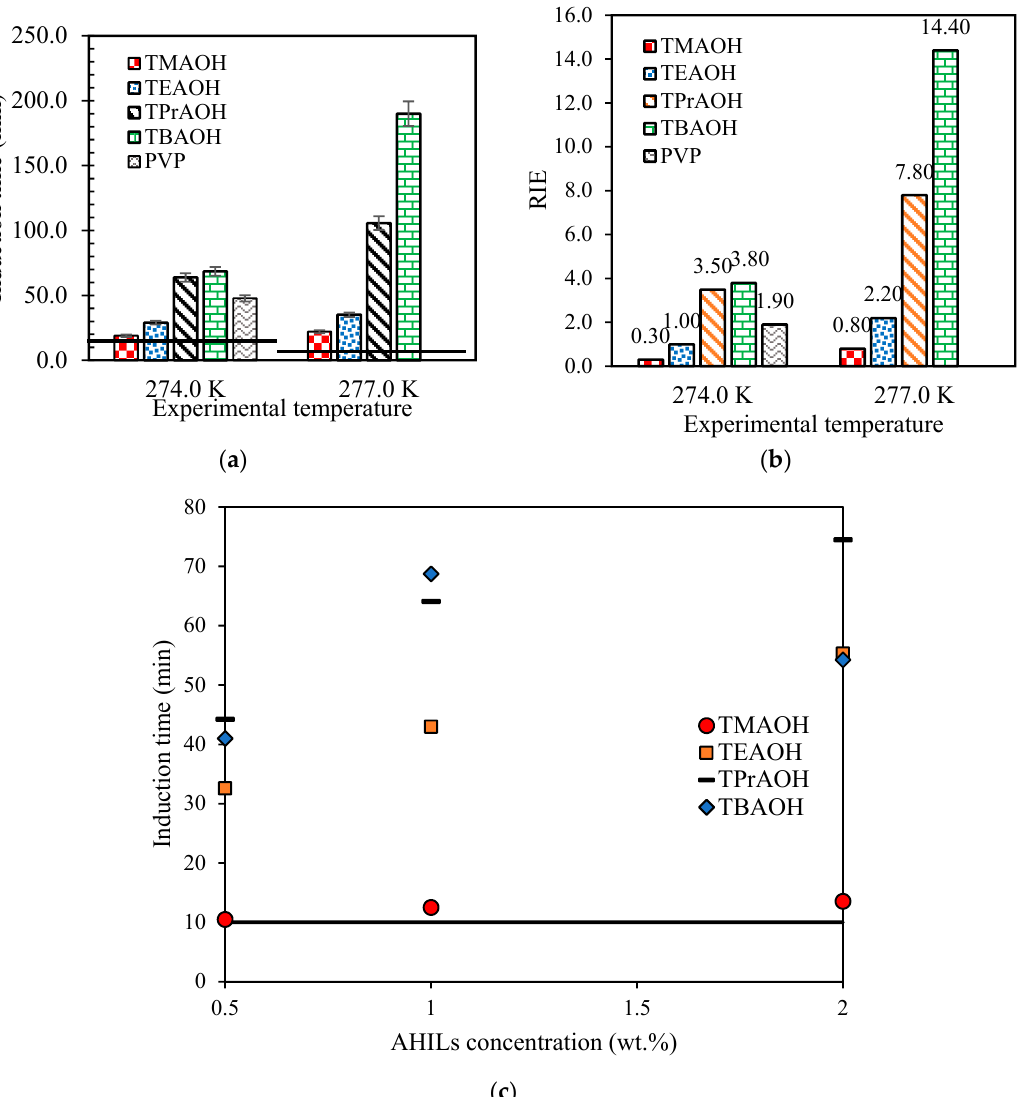
Figure 4. Effect of AHILs on the measured CO 2 hydrate induction times at different experimental temperatures at 1 wt.%: ( a ) Induction time at 274.15 and 277.15 K; ( b ) RIE for CO 2 hydrate system; ( c ) Effect of AHILs concentrations on the CO 2 hydrate formation induction time at 274.15 K; The black line symbolizes pure water values; No hydrate formation was observed for PVP at 277.0 K.